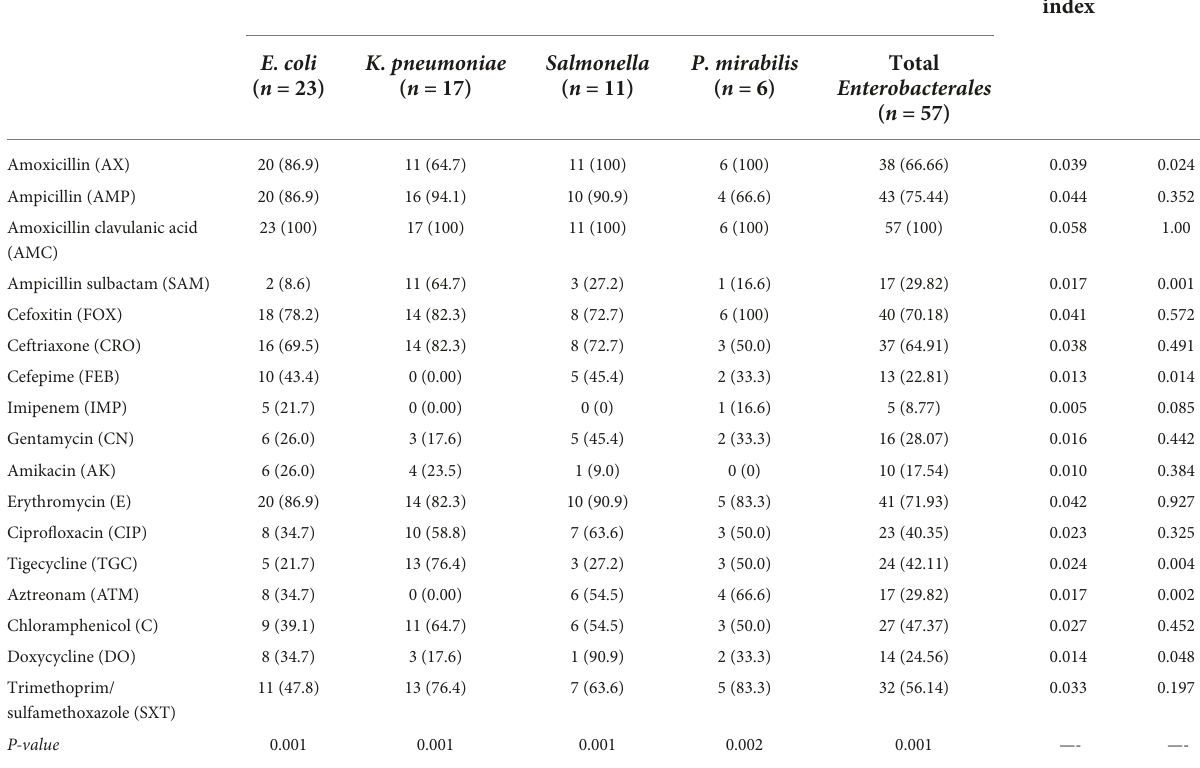
TABLE 2 Antimicrobial resistance of Enterobacterales isolates ( n = 57) recovered from human and animal origins. Antimicrobial